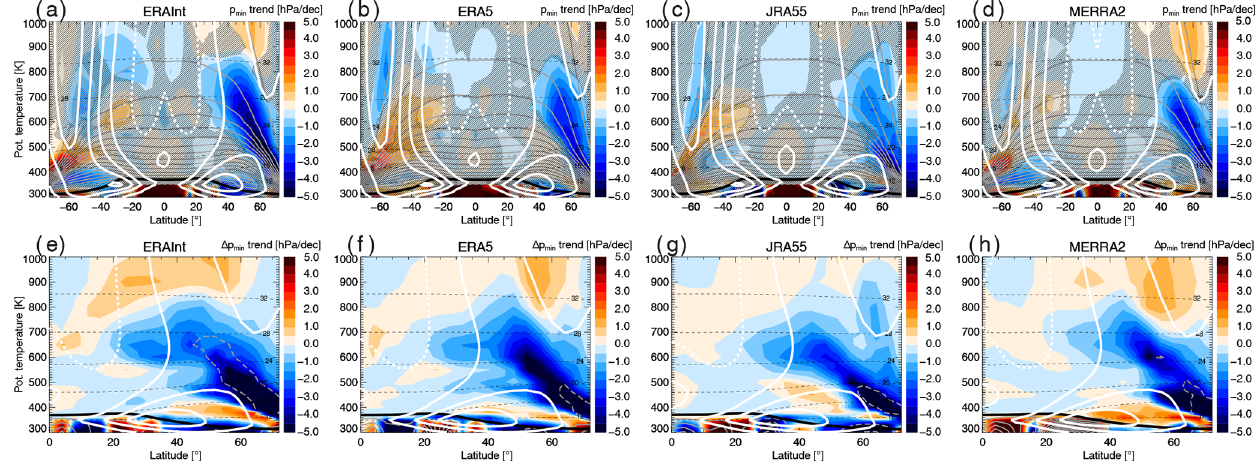
Figure 7. (a–d) Trends of minimum pressure along residual-circulation trajectories p min for the period 2005–2017 for ERA5, ERA-Interim, JRA55 and MERRA2. (e–h) Hemispheric difference in p min trends (NH minus SH) for the different reanalyses. Grey lines show climato- logical p min (a–d) and the NH trend values ( e–h ; solid for positive, dashed for negative values), white lines show zonal wind contours (solid for positive, dashed for negative values), thin dashed black lines show log-pressure altitude levels, and the thick black line shows the WMO